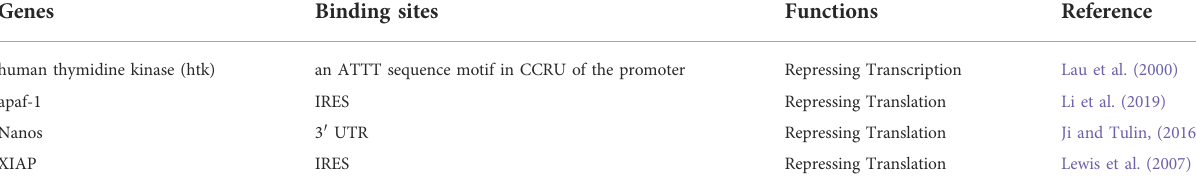
TABLE 3 The transcription and translation of genes repressed by hnRNP